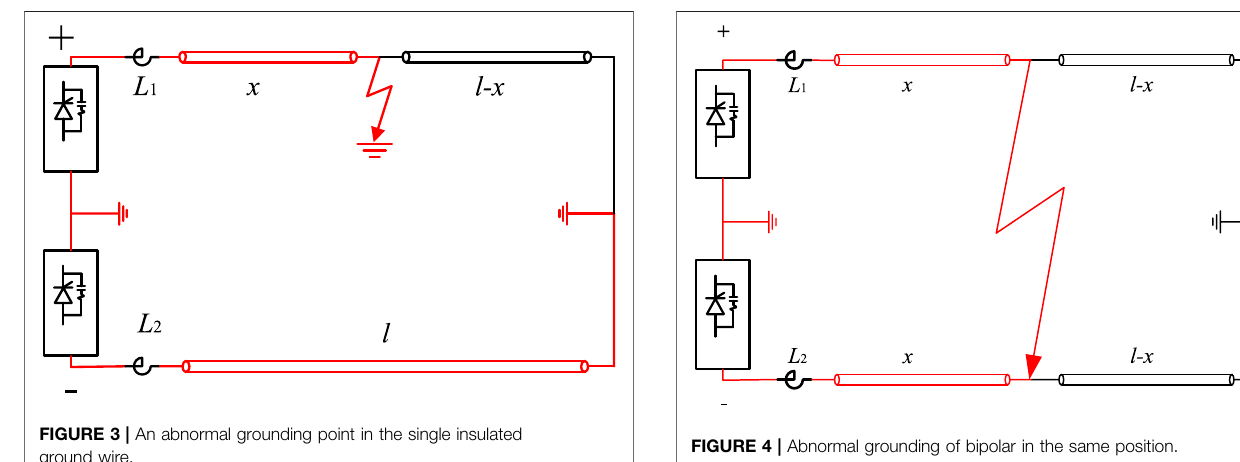
FIGURE 4 | Abnormal grounding of bipolar in the same position.